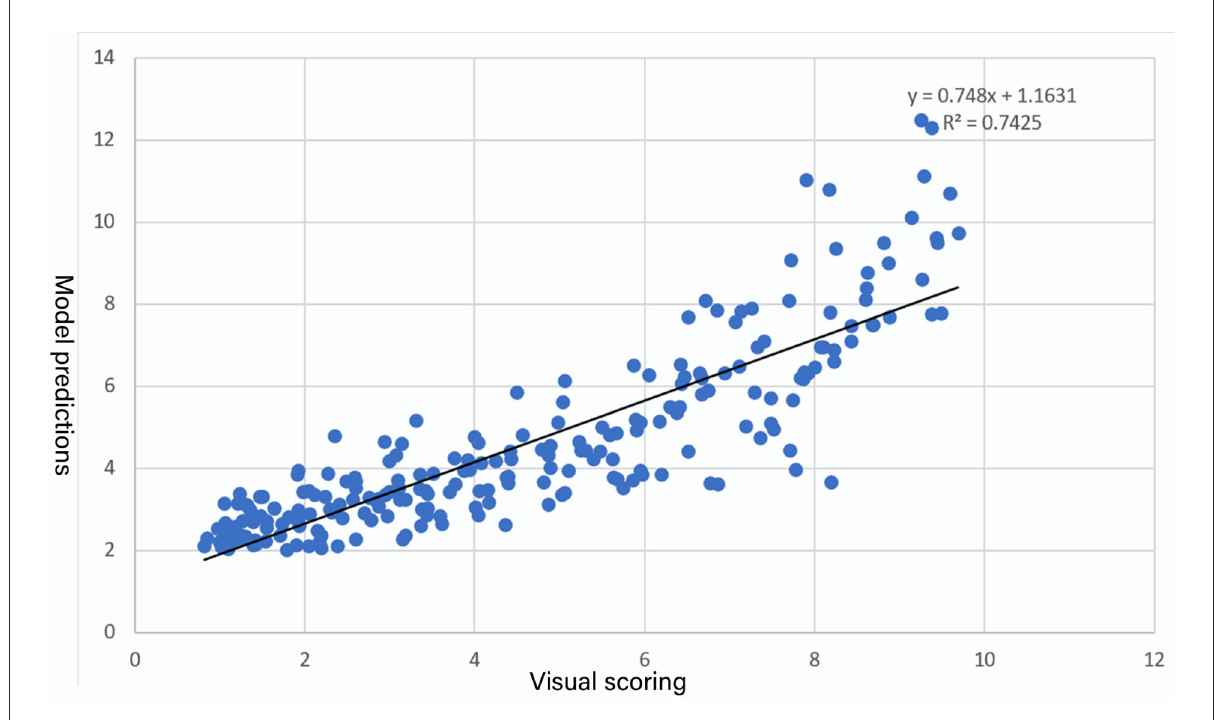
FIGURE7 Scatter plot between visual scoring and model